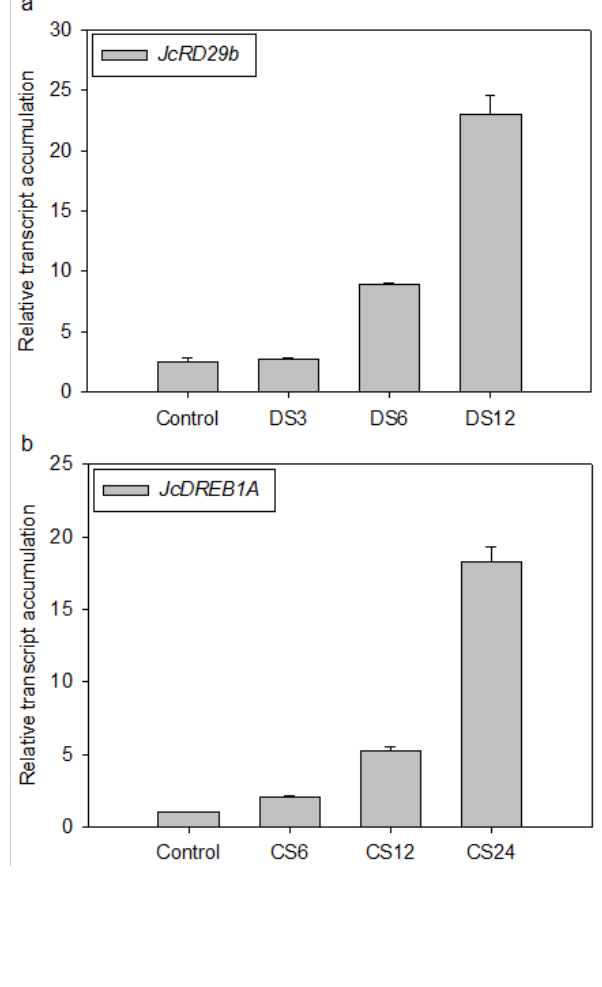
Figure 4. Normalized transcript accumulation of two stress-responsive genes of Jatropha , as determined by RT-qPCR analyses. ( a ) Expression profile of JcRD29b relative to TUB5 and TUB8 in samples exposed to desiccation stress (DS) for 0 (control), 3, 6 and 12 h; ( b ) Expression profile of JcDREB1A relative to GAPDH and actin in samples exposed to cold stress (CS) at 4 °C for 0 (control), 6, 12 and 24 h; ( c ) Comparison of JcRD29b expression profiles relative to the two most stable reference genes ( TUB5 and TUB8 ) and the two unstable reference genes ( GAPDH and UBQ-LIKE ) in samples exposed to desiccation stress (DS) for 0 (control), 3, 6 and 12